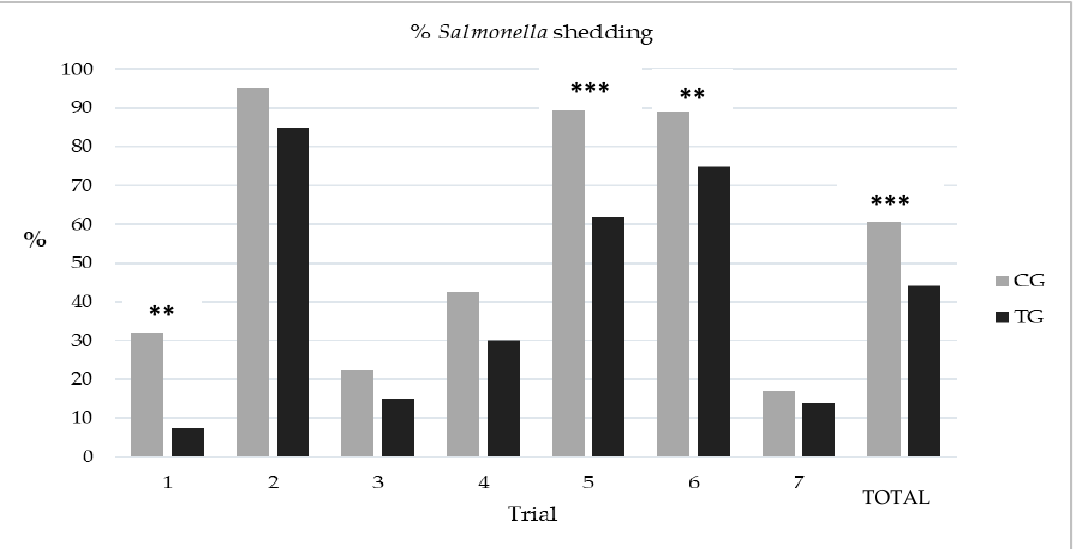
Figure 1. Proportion of Salmonella shedding at slaughter in the seven trials and globally. Significant differences between the control (CG) and the treated group (TG) are indicated (** p < 0.05; *** p < 0.01; Fisher´s exact test).